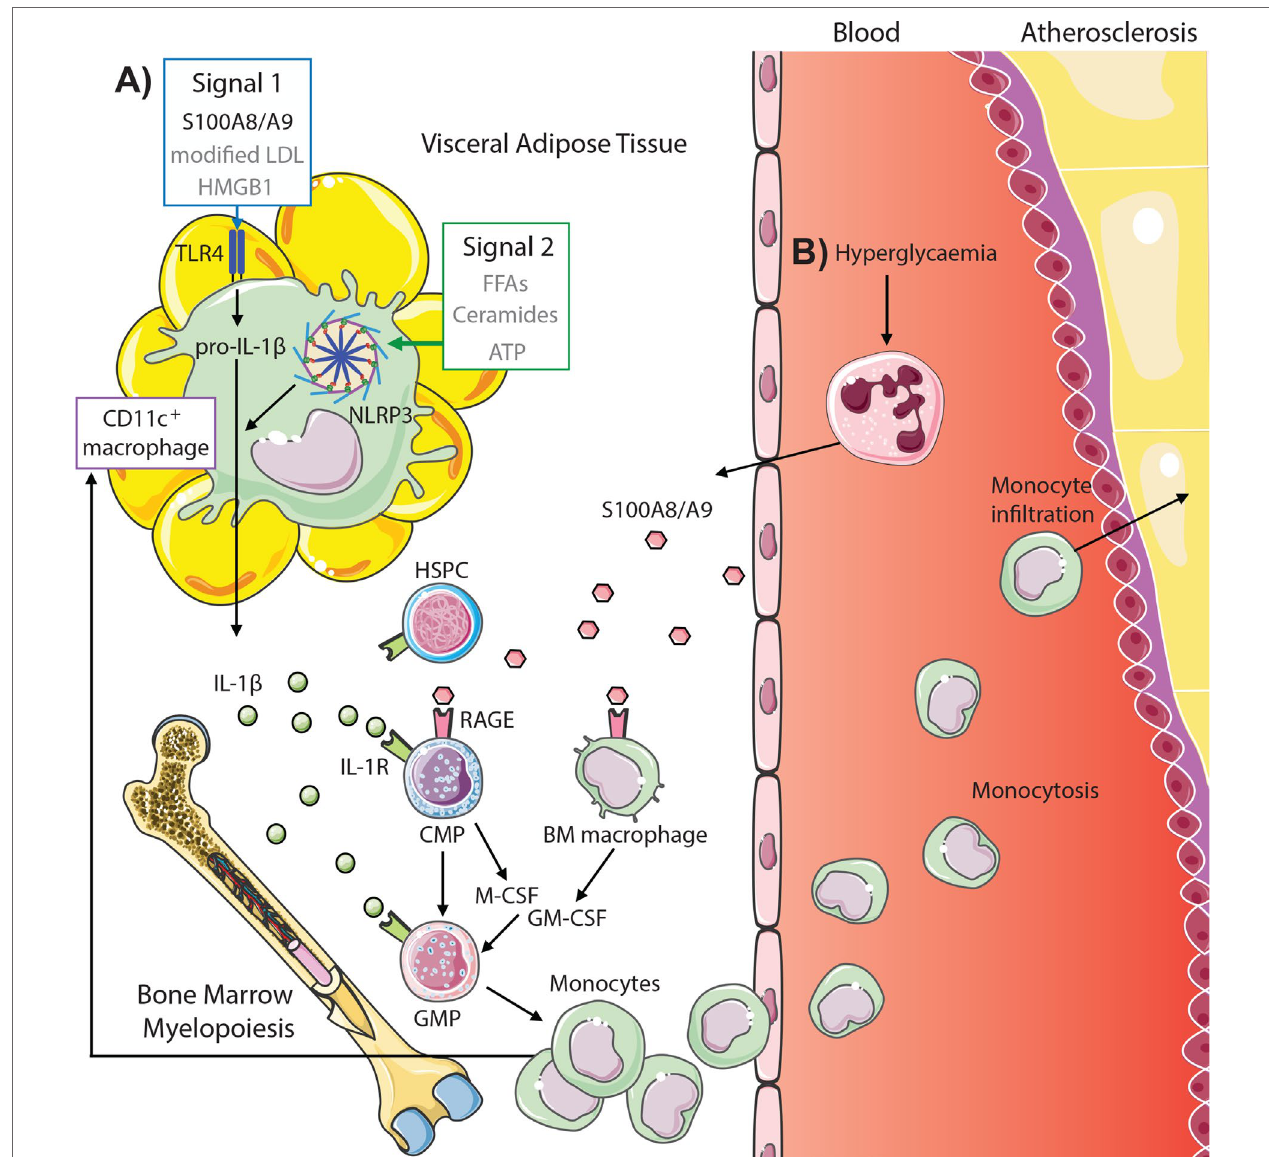
FIGURE 2 | S100A8/A9 drives myelopoiesis and monocytosis in diabetes and obesity. (A) Adipose tissue inflammation in obesity promotes monocytosis through S100A8/A9-TLR4 signaling on CD11c + adipose tissue macrophages (signal 1, other potential mediators in gray) and activation of the NLRP3 inflammasome (signal 2) to promote IL-1 β , which signals through the IL1R on common myeloid progenitors (CMPs) and granulocyte–macrophage progenitors (GMPs) to induce myelopoiesis. This results in both increased circulating monocytes and feeds back to increase CD11c + macrophages. (B) Hyperglycemia promotes monocytosis by direct signaling of neutrophil-derived S100A8/A9 via RAGE on CMPs and macrophages in the bone marrow, promoting CMP and GMP proliferation and differentiation via autocrine and paracrine (M-CSF and GM-CSF) signaling, respectively. These monocytes infiltrate atherosclerotic lesions to promote atherogenesis (further detailed in Figure 1